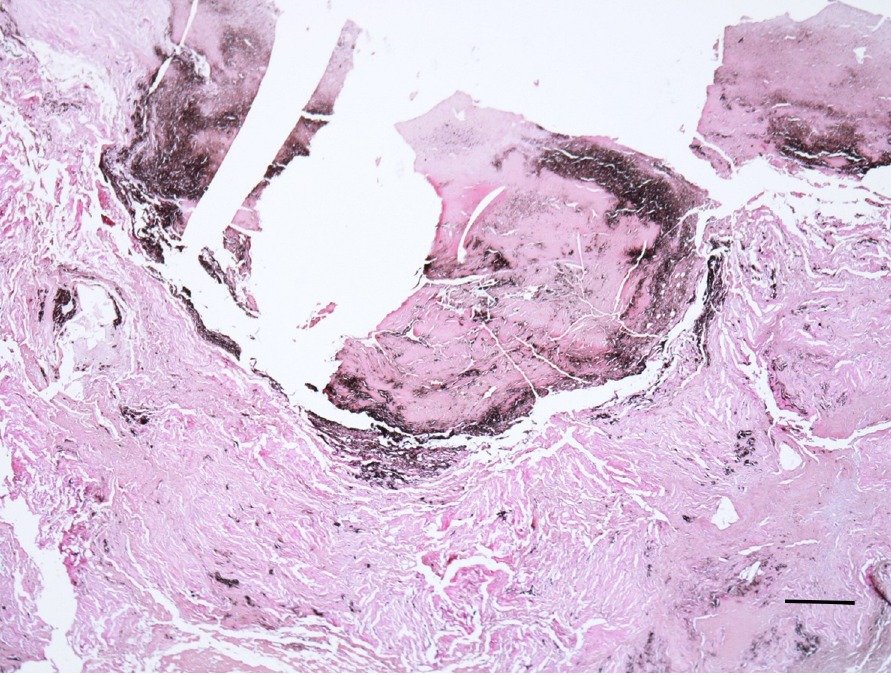
Fig 14. Histological section of hilar nodular condensation of the right lung showing scar-like fibrosis and significant anthracosis. Despite decalcification prior to the preparation there are unfortunately some artefacts from the calcifications (H&E); bar = 200 μ